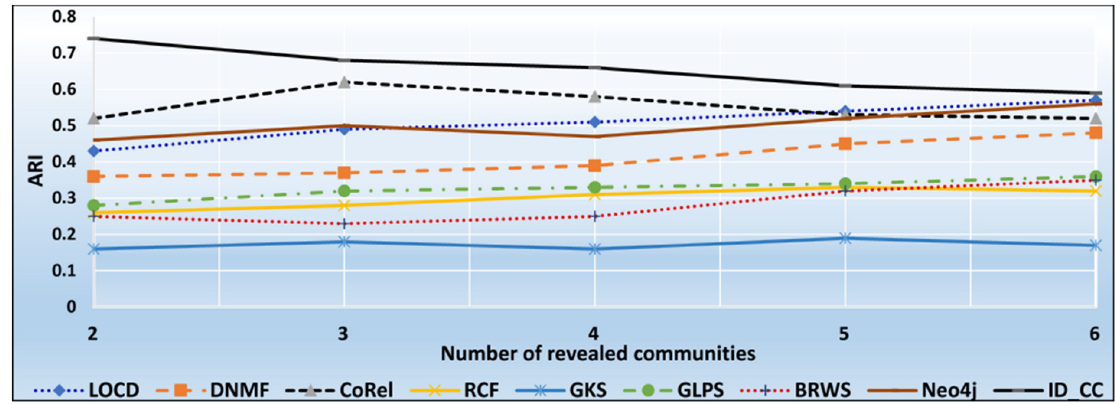
Fig 22. The accuracy of each method in terms of ARI for detecting the DBLP cross-communities resulted from the overlapping of m number of communities ( m = 1, 2, ... , 6).